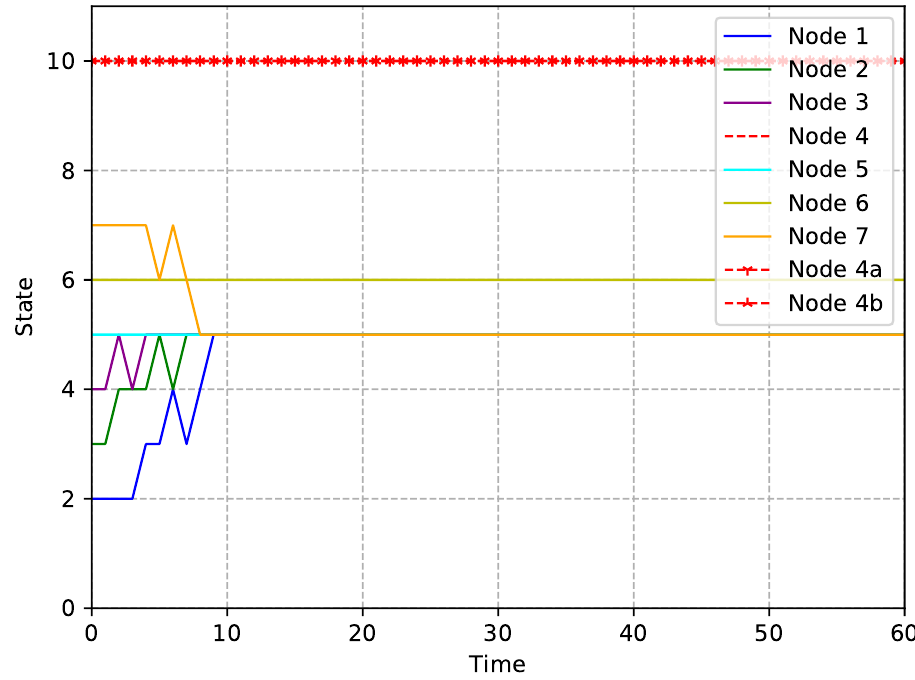
Figure 10. Simulation results of proposed algorithm under (2,1)-robust network.